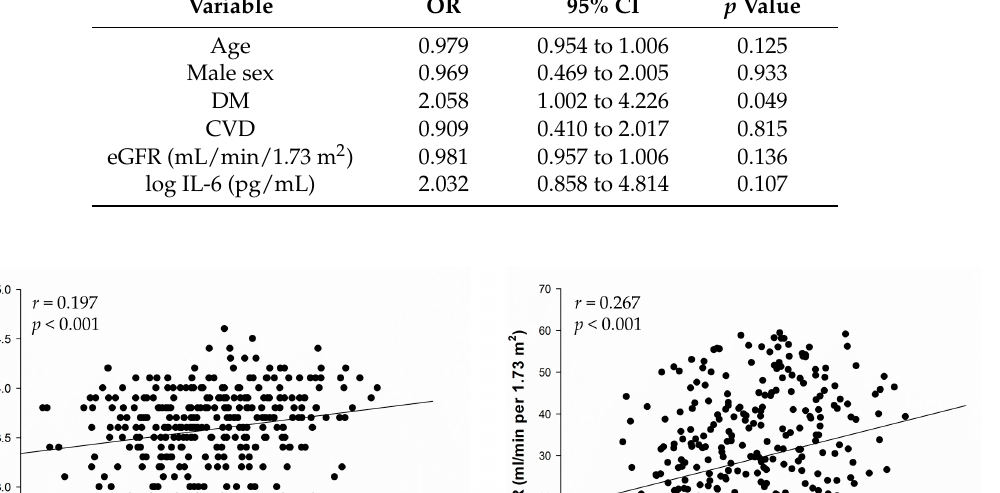
Table 2. Stepwise multivariate linear regression model identifying determinants of LTI.